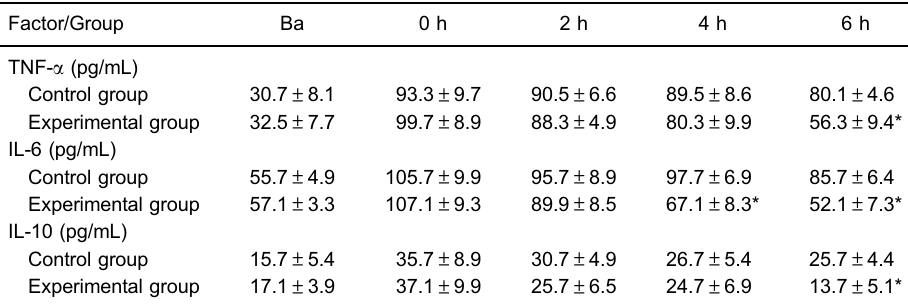
Table 3. In fl ammatory factor levels in the serum of male pigs induced with acute respiratory distress syndrome that received continuous veno-venous hemo fi ltration therapy (experimental) or conventional supportive therapy (control).